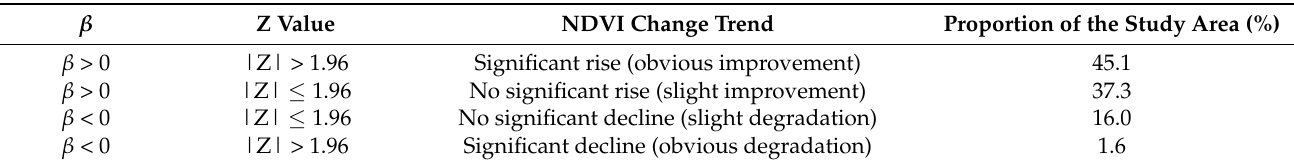
Table 3. Classification and area proportion statistics of the NDVI change trends.